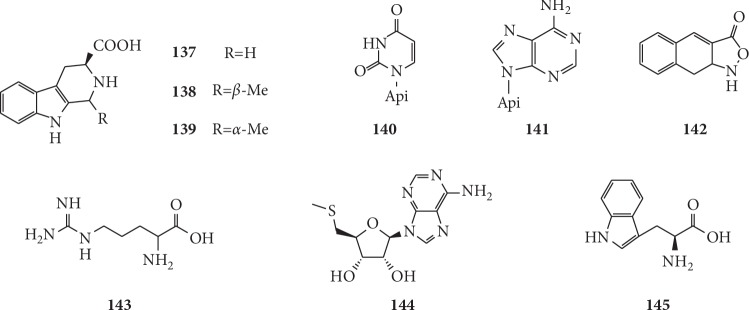
Structures of nitrogen compounds in G. littoralis.